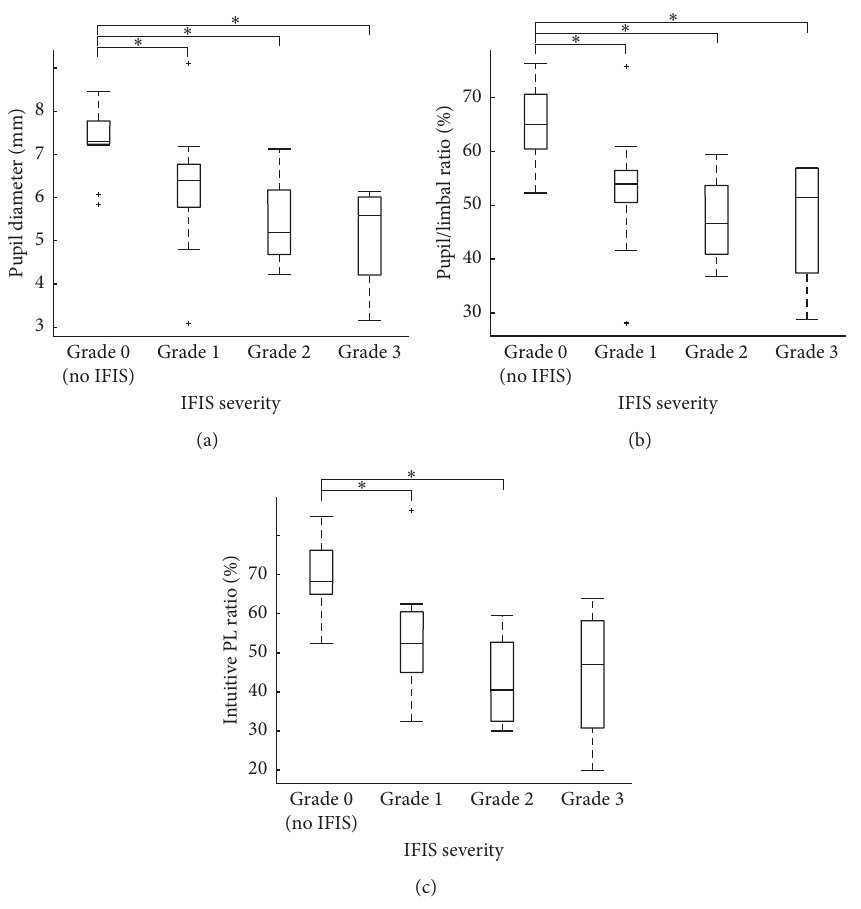
Figure 2: Box and whisker plot showing intraoperative floppy iris syndrome (IFIS) severity in the α 1-ARA group. (a) IFIS severity and pupil diameter. (b) IFIS severity and the pupil-to-limbal diameter (PL) ratio. (c) IFIS severity and the intuitive PL ratio. There was significant difference between Grade 0 and not only Grade 1 but also Grades 2 and 3 in pupil diameter and PL ratio ( p < 0 . 05). The intuitive PL ratio in Grade 0 cases was significantly larger than the ratios in Grade 1 and 2 cases ( p < 0 .